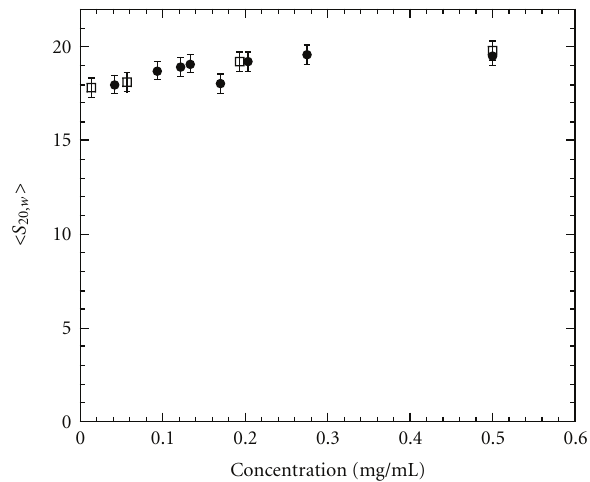
Figure 3: Fluorescence versus time of AC-Hsp27 plus F-actin. Fluorescence at 485 nm of 1 μ M AC-Hsp27 versus time after addition of 40 μ M F-actin in F-bu ff er at 37 ◦ C. The saturated fluorescence value of 432 ± 6 fluorescence units was obtained from an unweighted, nonlinear least squares double exponential fit of the data points and the root mean square deviation of the points from the